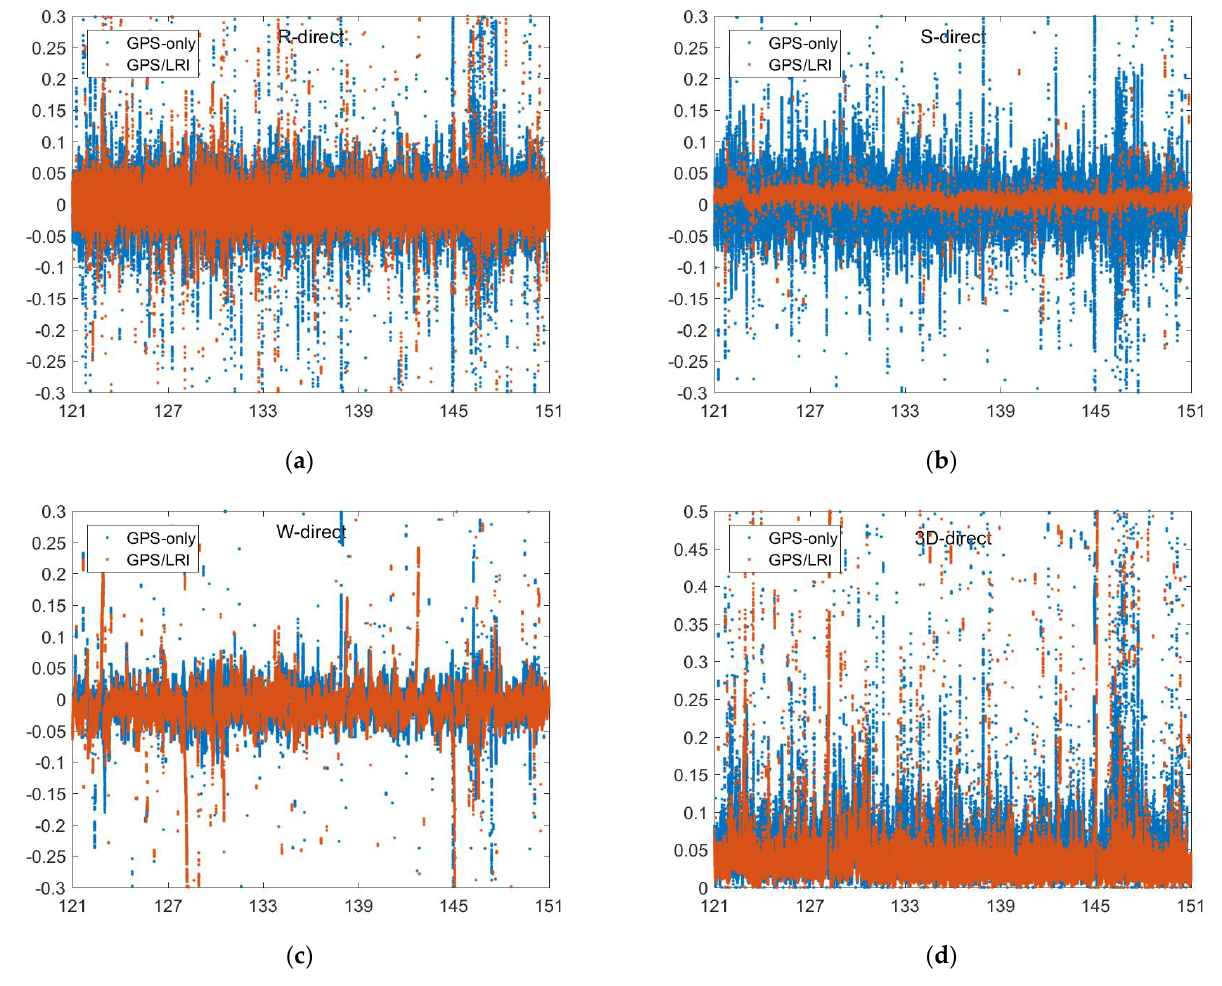
Figure 7. Reference orbit check for GRACE-FO-A in the R, S, W, 3D directions (days 121-151, ( a – d )).